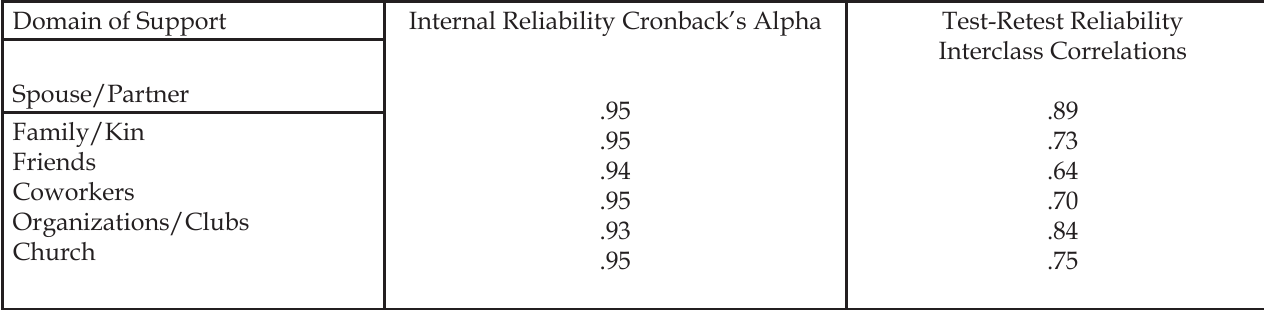
Table VI. Internal and test-retest reliability